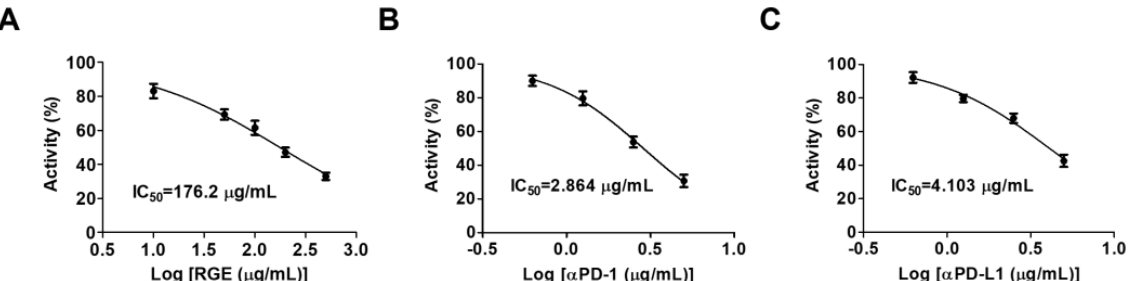
Figure 1. RGE blocks the human PD-1/PD-L1 interaction activity in vitro. ( A ) RGE blocks the hPD-1/hPD-L1 interaction as determined by competitive ELISA. ( B , C ) Human PD-1 neutralizing antibody ( B ) and human PD-L1 neutralizing antibody ( C ) act as positive controls. The assays were performed in triplicate at each concentration.